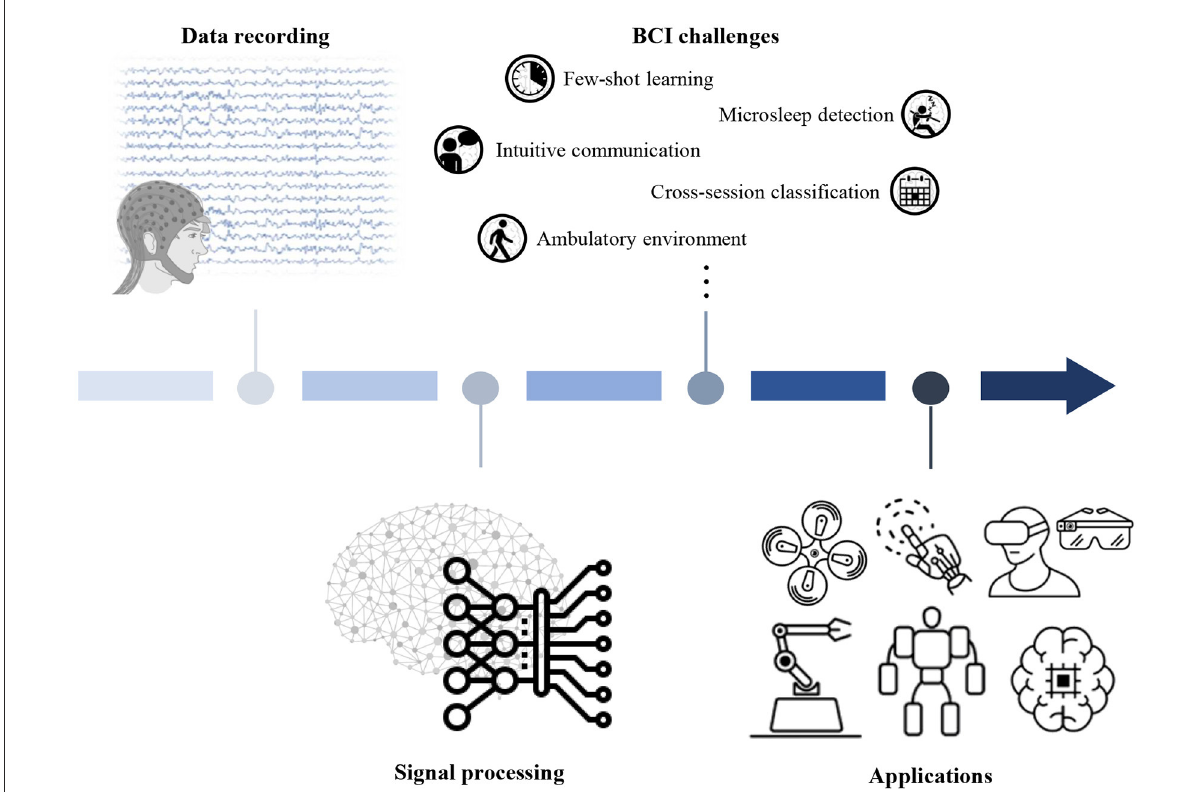
FIGURE1 Overview of noninvasive BCI. Every BCI begins its analysis with meaningful feature extraction through signal processing, starting with data recording. Researchers decode EEG data collected from experimental environments suitable for each study using advanced methodologies to develop BCI